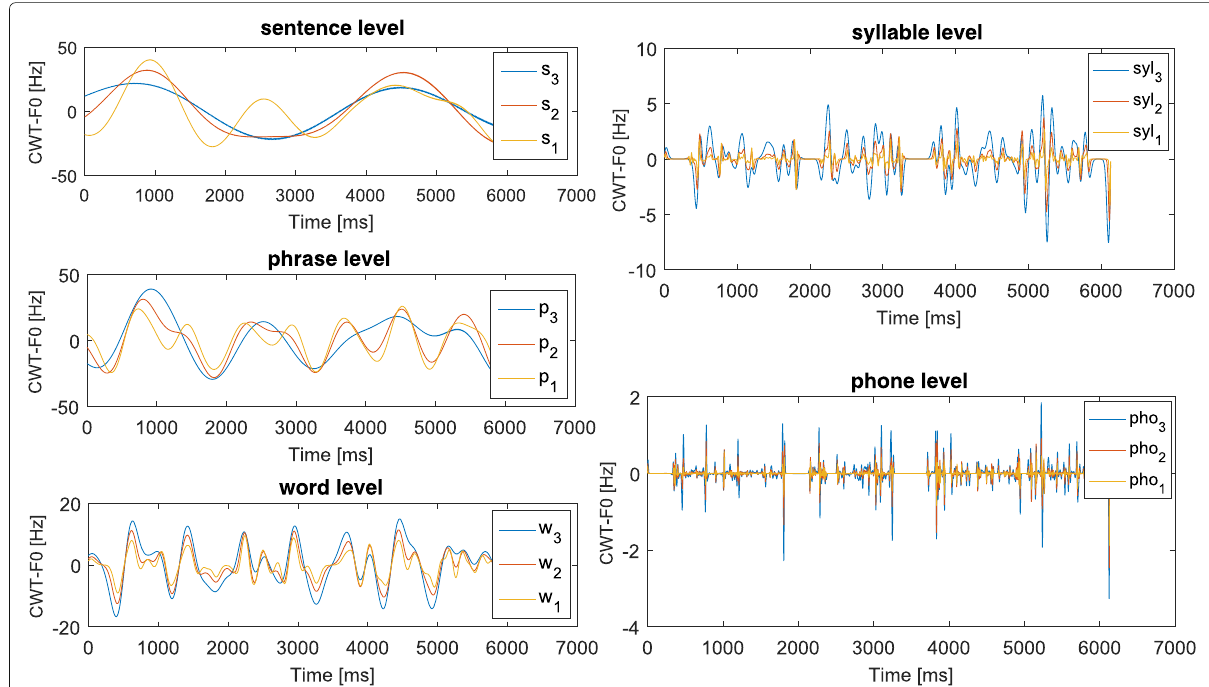
Fig. 4 Example of sentence, phrase, word, syllable, and phone level scales when the number of each level ( λ ) is set to 3. The red , blue , and yellow curves represent the scales in each level when temporal duration ( D i ) is calculated with i = 1, i = 2, and i = 3,